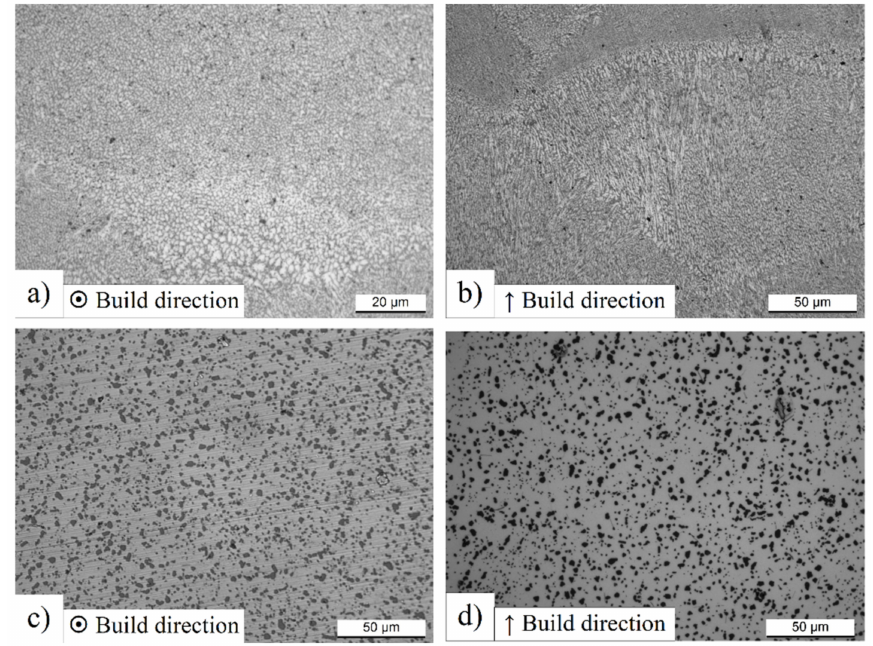
Figure 4. High magnification micrographs of SL AlSi10Mg DL-90 ( a – c ) and SL-50 ( d ) microstructure after 200 ◦ C/4 h ( a , b ) and T6 (505 ◦ C/4 h + 175 ◦ C/4 h) HT ( c , d ). The first and second columns are referred to XY plane and XZ plane,